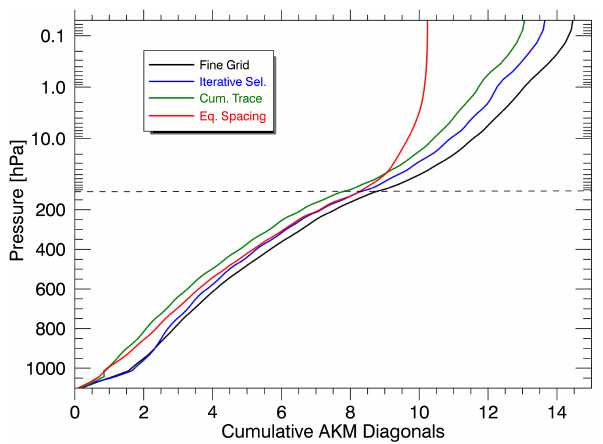
Figure 8. Histograms of 15 equally spaced bins showing the percent loss in DFS by using a coarse vertical grid with equal pressure spac- ing vs. the coarse grid from the iterative method. The dotted vertical lines show the median values of the 80-atmosphere